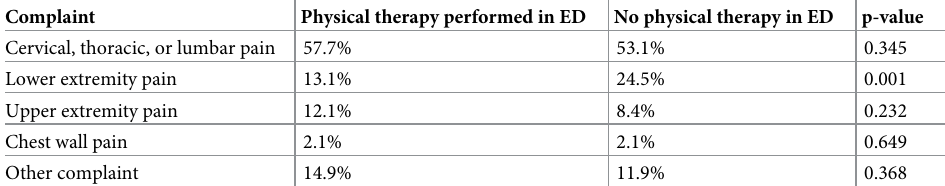
Table 2. Comparison of presenting chief